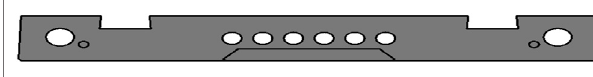
FIGURE 6 | PCAT on-street slab cross-section. Isometric views can be seen in Figures 4 , 5 .